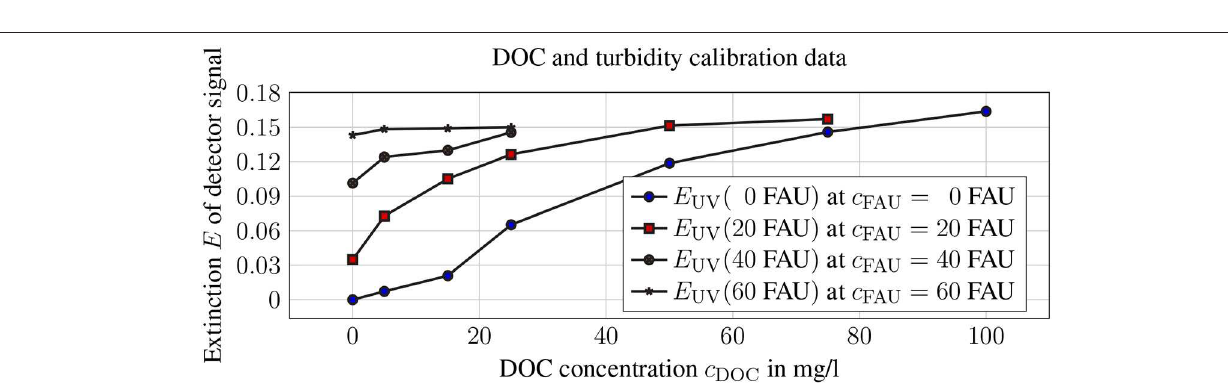
FIGURE 9 | Extinction E UV of the UV detector signal in relation to DOC concentration and the corresponding turbidity values.